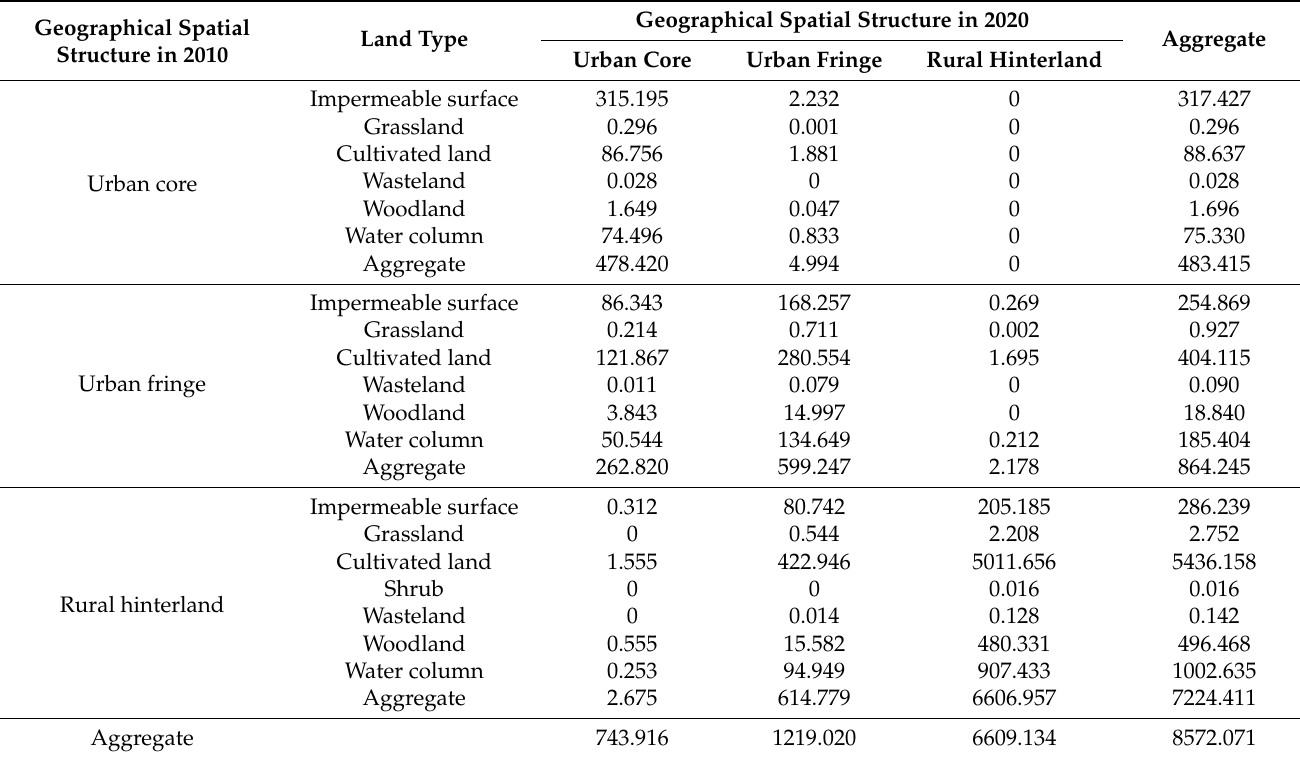
Table 13. Land-use transfer matrix for the urban geographic structure of Wuhan City, 2010–2020 (unit: km 2